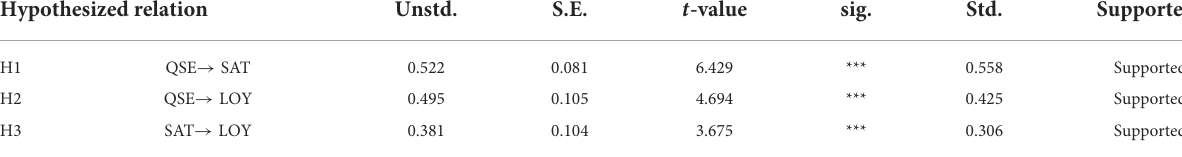
TABLE 6 Hypothesized relation.